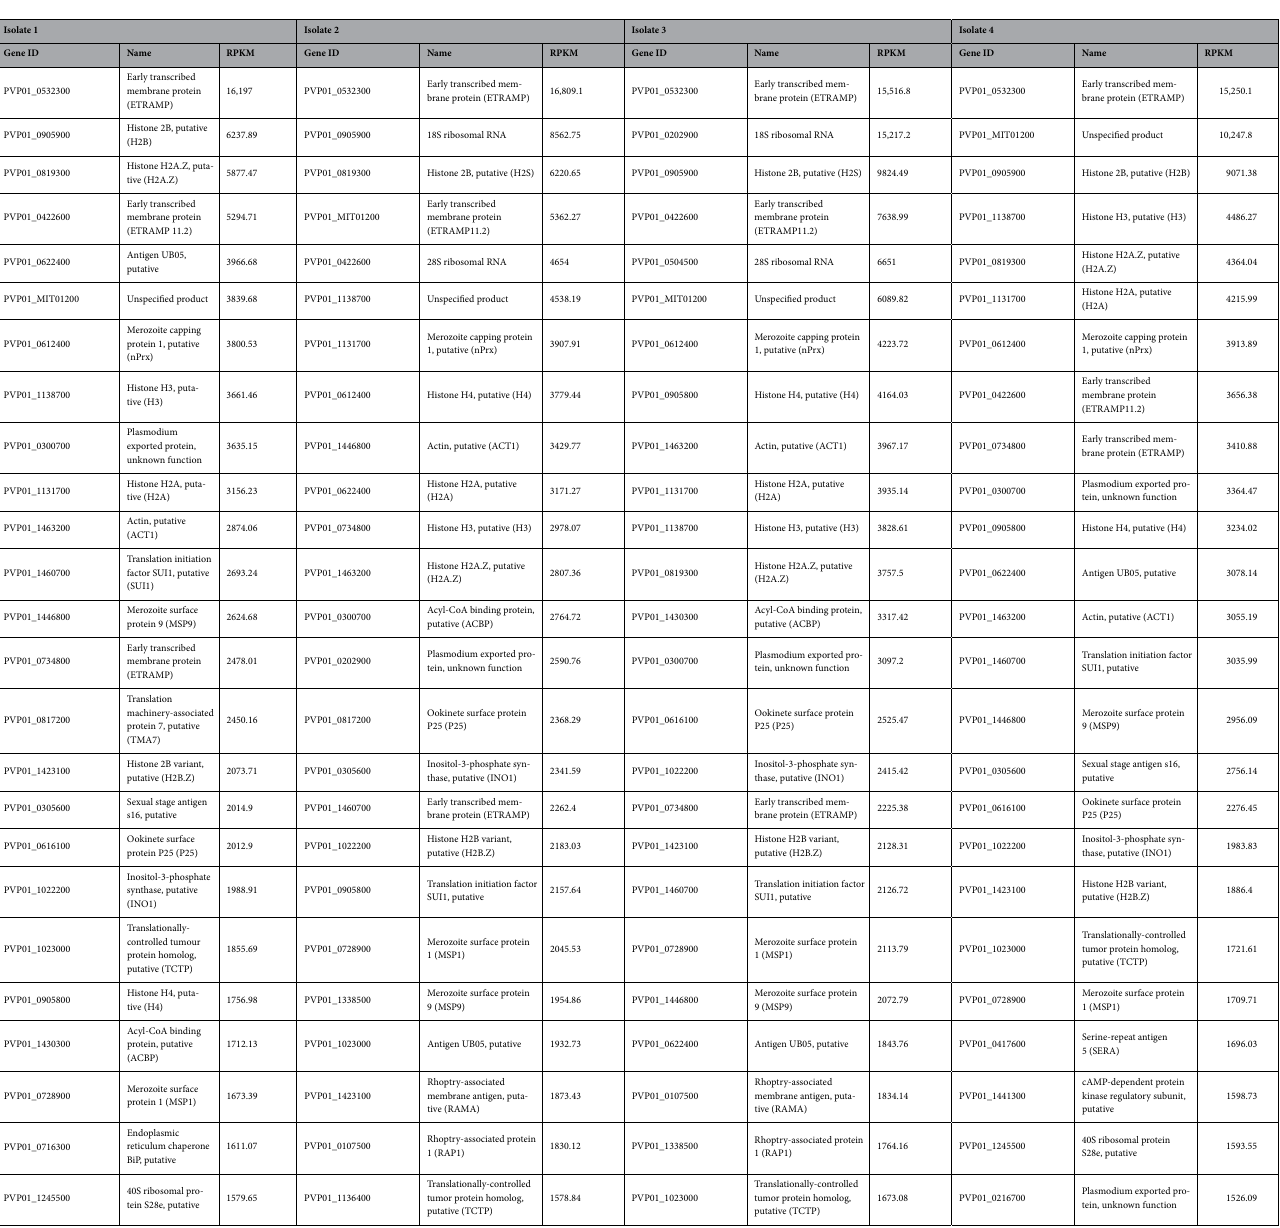
Table 1. List of the 25 most expressed genes in each sample